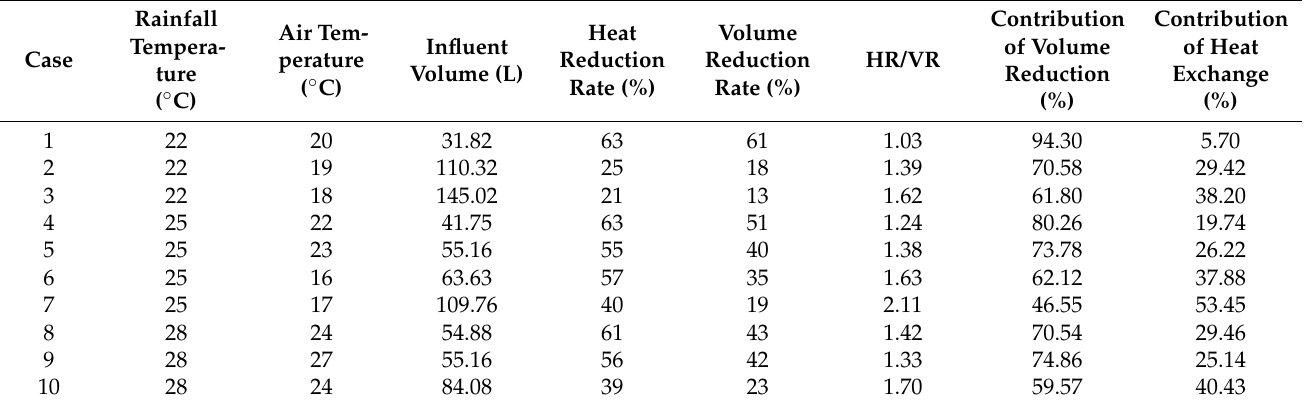
Table 3. Experimental results of rain heat-pollution-load reduction.